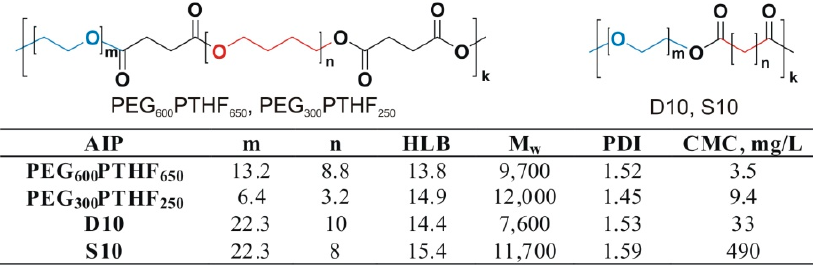
Figure 2. Chemical structure and characteristics of the representative AIPs. D10 is made from dodecanedioic acid and polyethylene glycol with an average Mn 1000 g/mol (PEG-1000). S10 is based on PEG-1000 and sebacic acid. The subscripted numbers indicate the average molecular weight of the copolymerized PEG and polytetrahydrofuran (PTHF) in the PEG-PTHF copolymers (reprinted with permission from [124], Copyright 2012, American Chemical Society).